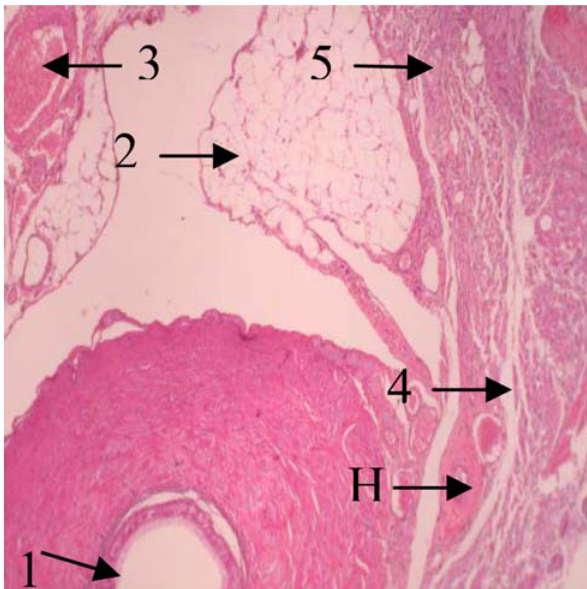
FIGURA 8 - Animal do grupo D - Cortes histológicos de fragmento de funículo espermático (1) com acentuada fibrose parietal, envolto por tecido fibroadiposo (2) com vasos sangüíneos ectasiados (3), necrose adiposa (4) granulomas do tipo corpo estranho (H), fibrose e com focos de moderado infiltrado linfoplasmocitário (5). Corado por H. E.